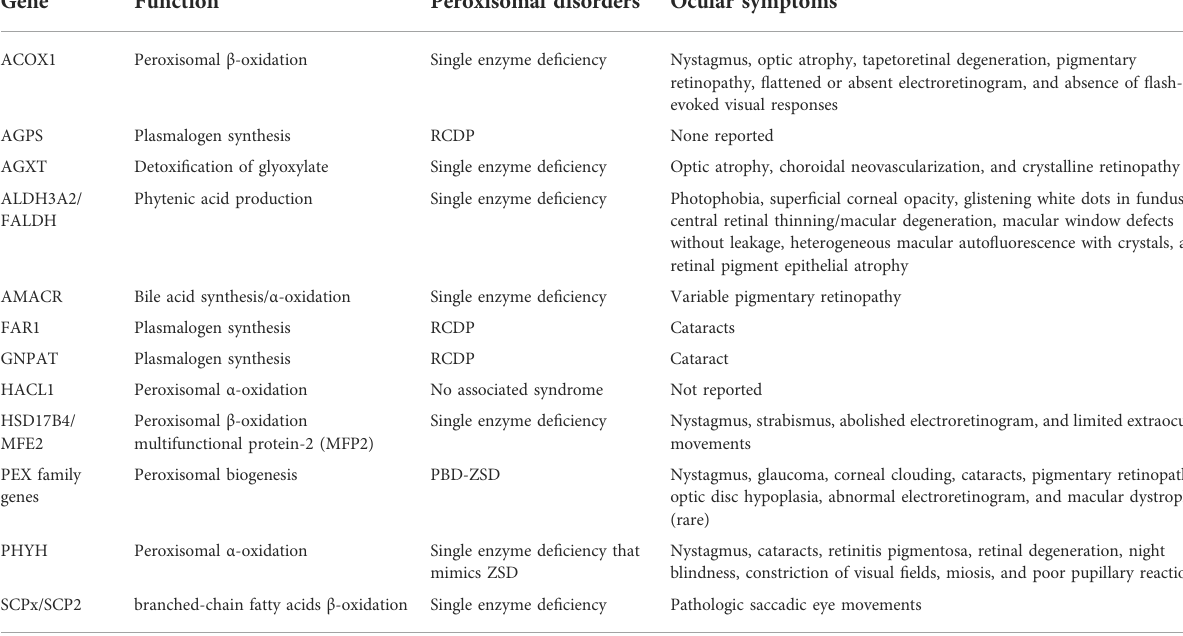
TABLE 1 Summary of common gene mutations and ocular symptoms in peroxisomal